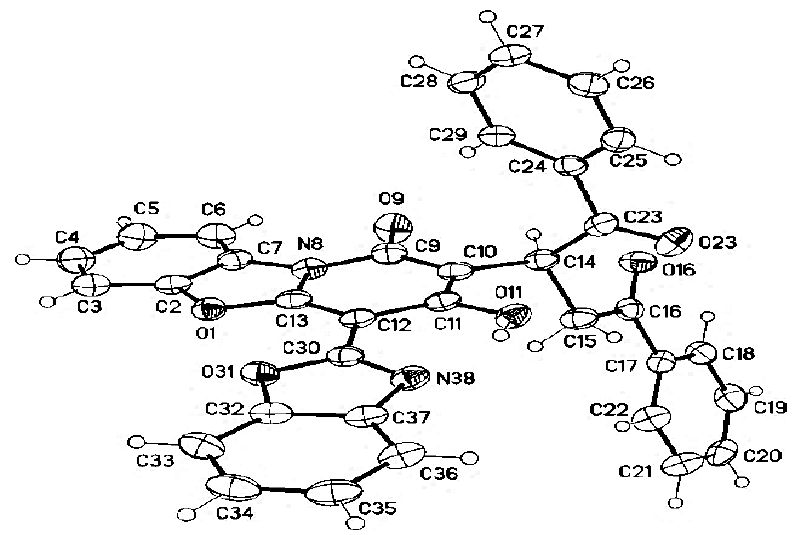
Figure 6. Molecular structure of compound 12 assigned as 2-(4-hydroxy-6-methyl-2-oxo-1,2-dihydroquinolin-3-yl)-1,4-diphenylbutane-1,4-dione.